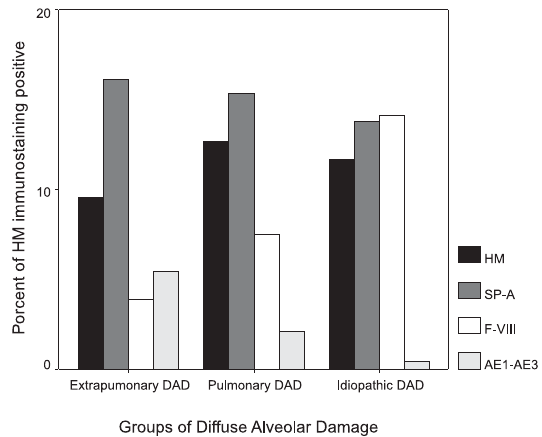
Figure 2 - Graphic illustration and quantitative analysis of hyaline membrane (HM) under hematoxylin & eosin staining and immunostained for surfactant apoprotein-A (SP-A), Factor VIII (F-VIII), and cytokeratin AE1/AE3 (AE1/ AE3) in extrapulmonary DAD, pulmonary DAD, and idiopathic DAD. The 1-way ANOVA procedure was used for analysis of variance of immunohistochemical stains and their distributions, and for the quantification of